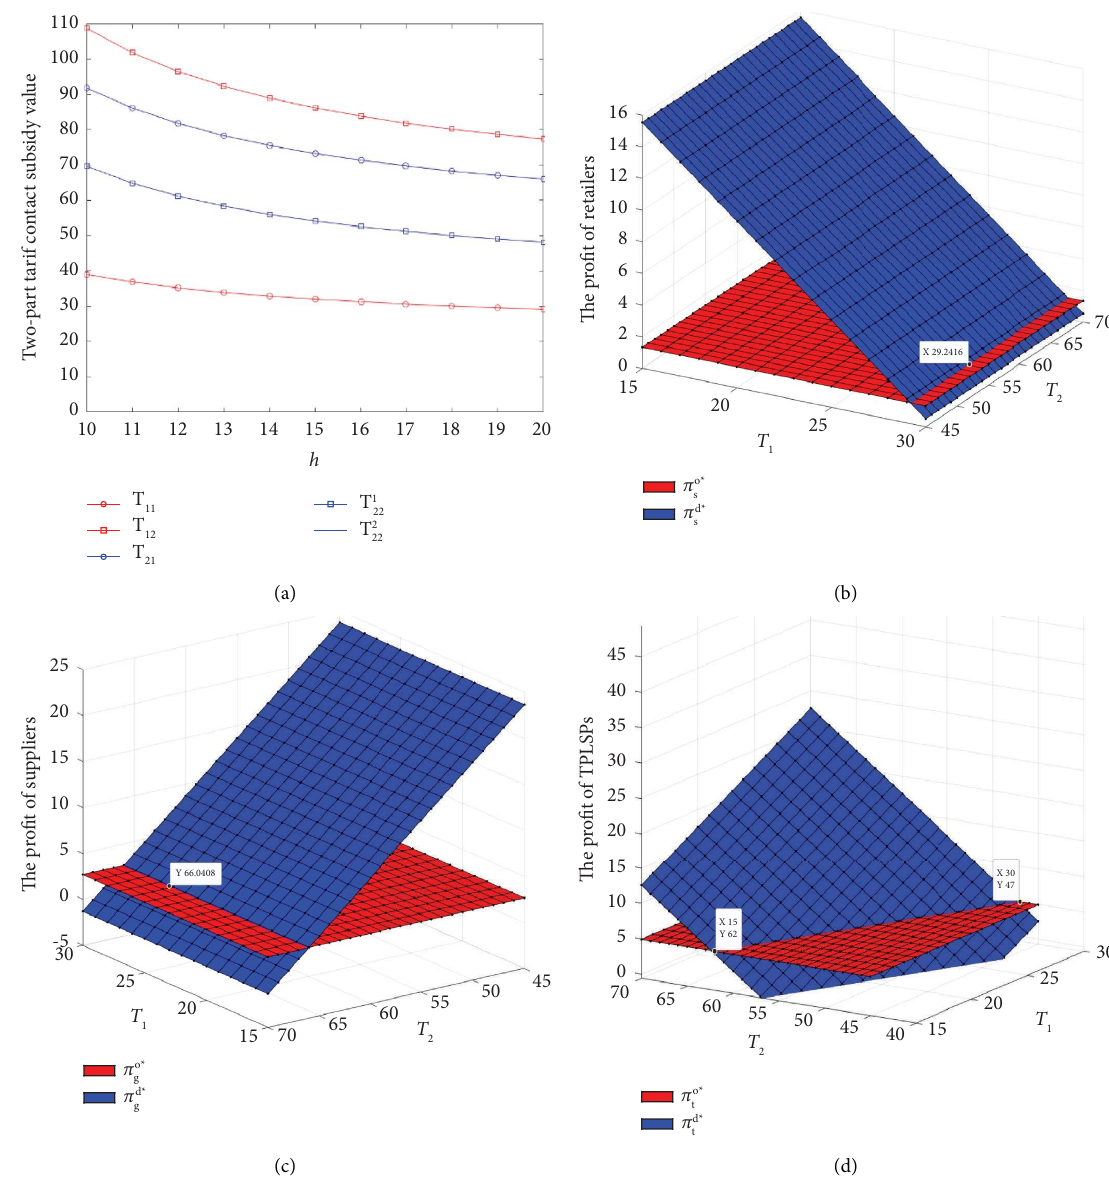
Figure 5: “Two-part tarif +revenue sharing +double cost sharing” contract change trend and its impact on